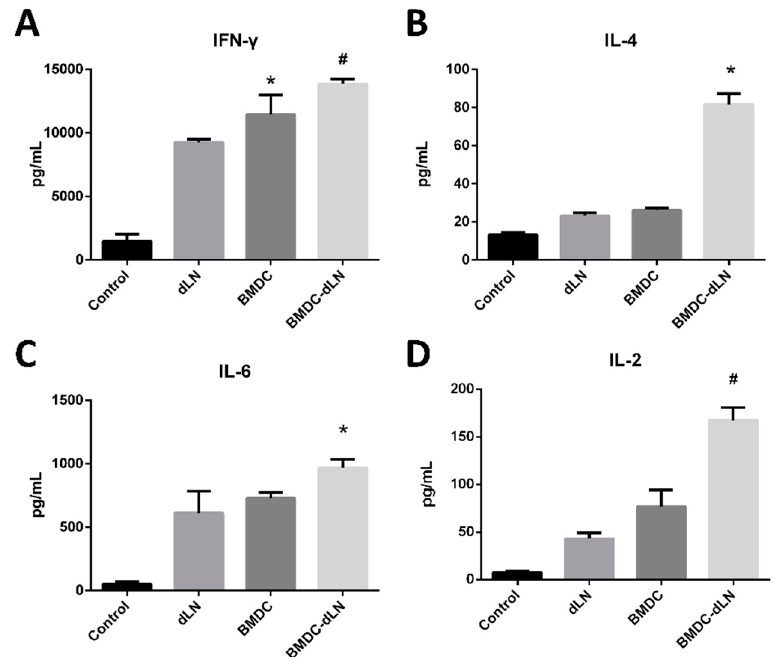
Figure 7. Cytokine production from splenocytes after ex vivo stimulation. Splenocytes from mice receiving different levels of immunization were obtained and cultured with 100 µg/mL OVA antigen for 3 d. The supernatants were collected, and ELISA was used to determine the production of cytokines ( A ) interferon gamma (IFN- γ ), ( B ) interleukin (IL)-4, ( C ) IL-6, and ( D ) IL-2. (Data are presented as the mean ± SD, *: p < 0.01, #: p < 0.001.).